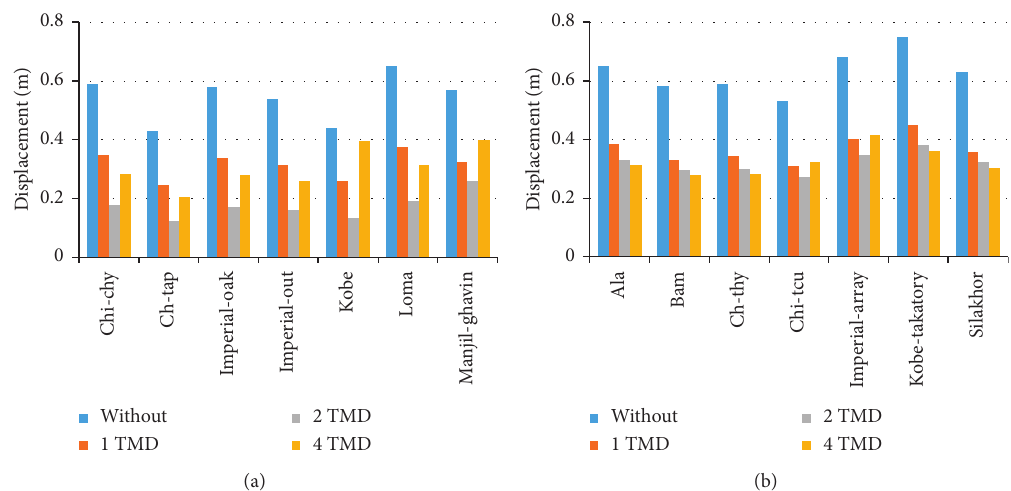
Figure 10: Maximum roof displacement under the near-field (right) and far-field (left) earthquakes in the regular 10-story model.